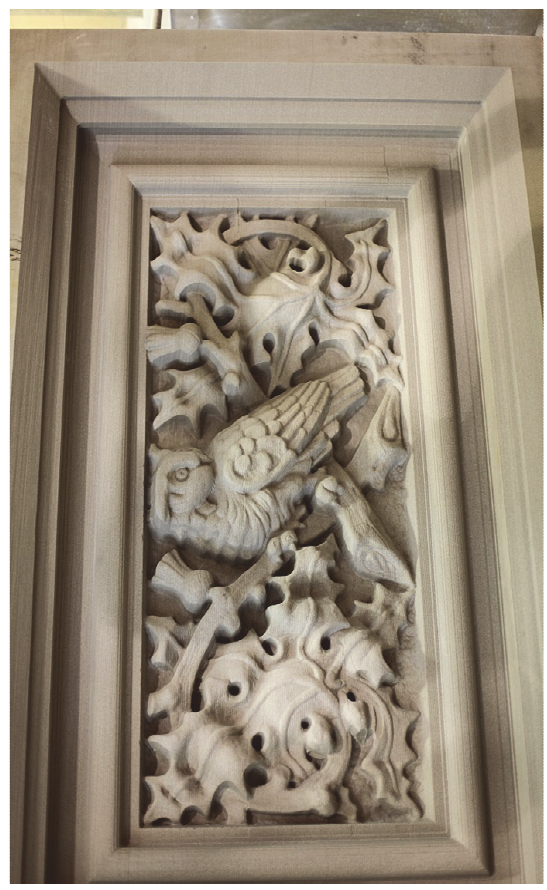
Figure 9. Robotically milled sandstone relief sculpture, prior to hand-applied finish